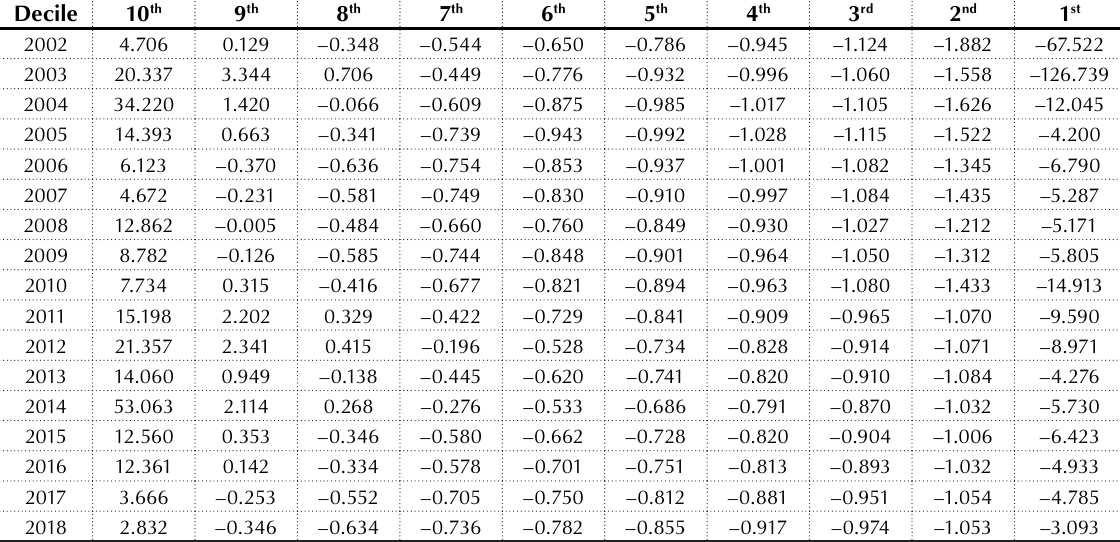
Table 8. The average market return adjusted three-year growth rate of